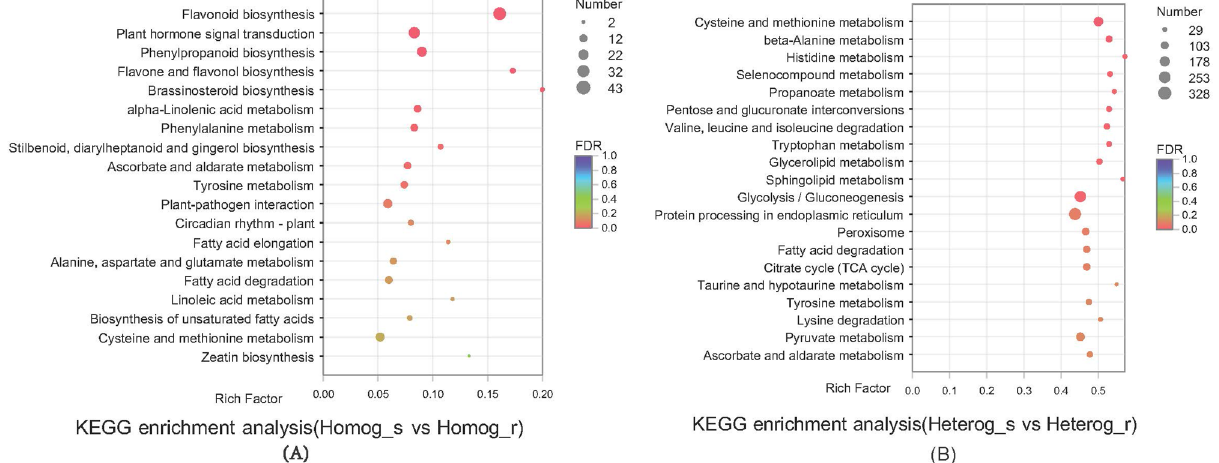
Figure 8. KEGG analysis of DEGs between scion and rootstock of two grafted groups, ( A ) Scion and rootstock of homologous grafts, ( B ) Scion and rootstock of heterologous